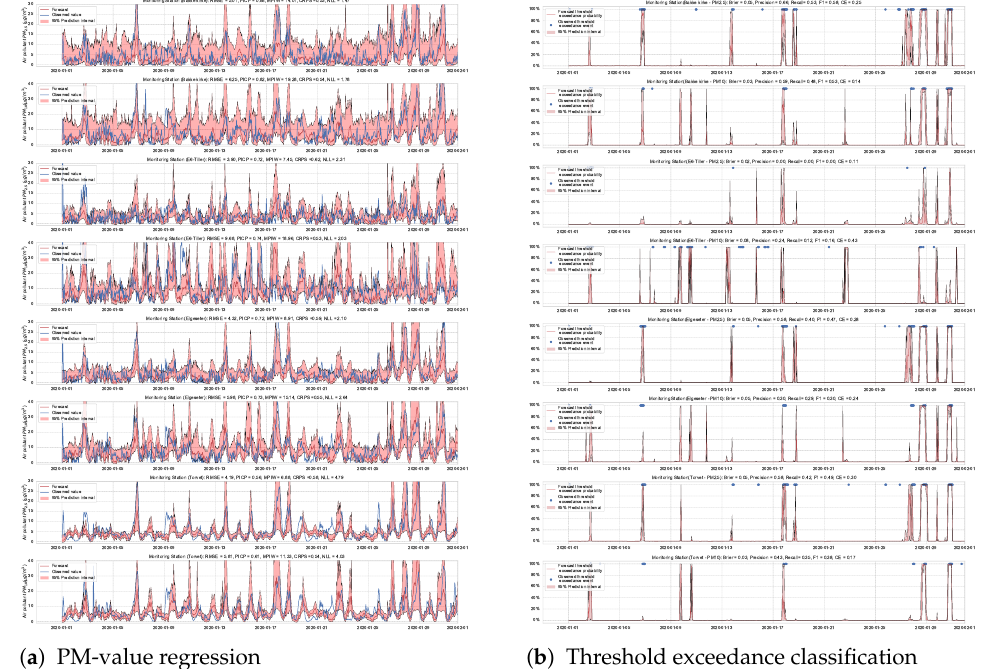
Figure A12. Deep probabilistic forecast of air quality using LSTM with MC dropout at four monitor- ing